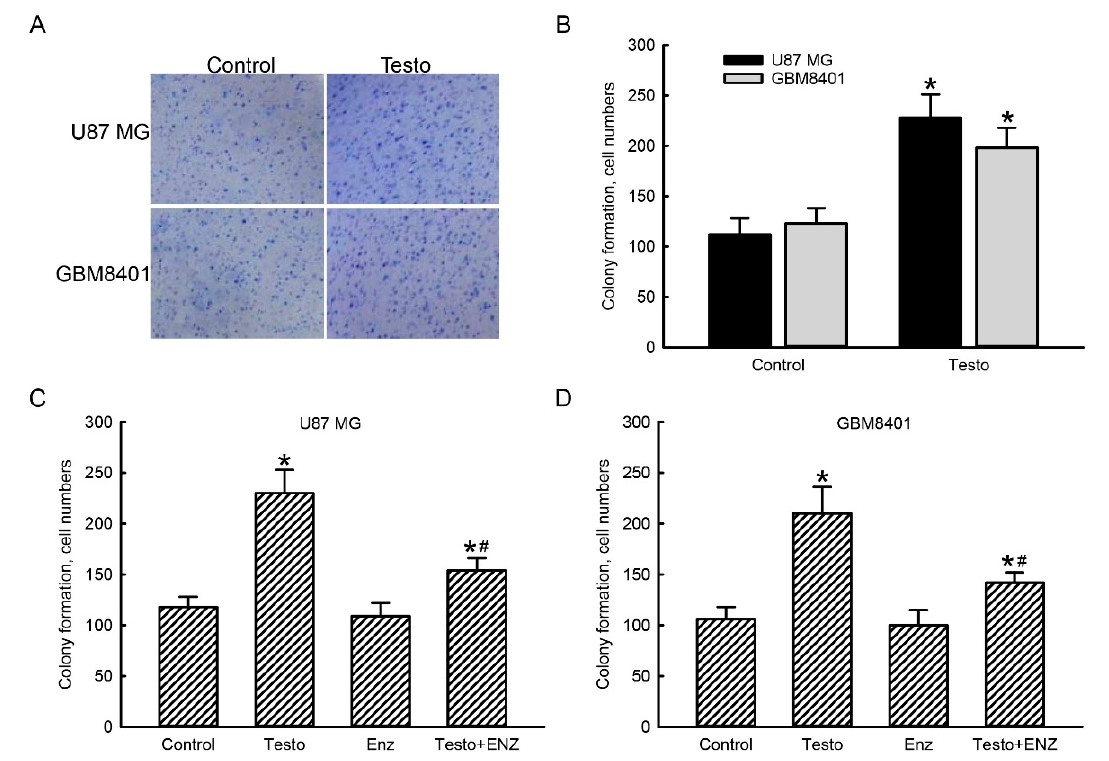
Figure 6. Contribution of the testosterone (testo) androgen receptor (AR) signaling axis to colony formation of human glioblastoma cells. Human U87 MG and GBM8401 glioblastoma cells were treated with 100 nM Testo for 72 h. A colony-formation assay was carried out. Representative cell colony images are shown ( A ). These colonies were quantified and statistically analyzed ( B ). Human U87 MG ( C ) and GBM8401 ( D ) glioblastoma cells were pretreated with 10 µ M enzalutamide (Enz) for 1 h and then exposed to 100 nM Testo for 72 h. Colony formation was assayed, quantified, and statistically analyzed. Each value represents the mean ± standard error of the mean for n = 6. The symbols * and # indicate that values significantly ( p < 0.05) differed from the control and testo-treated groups, respectively.